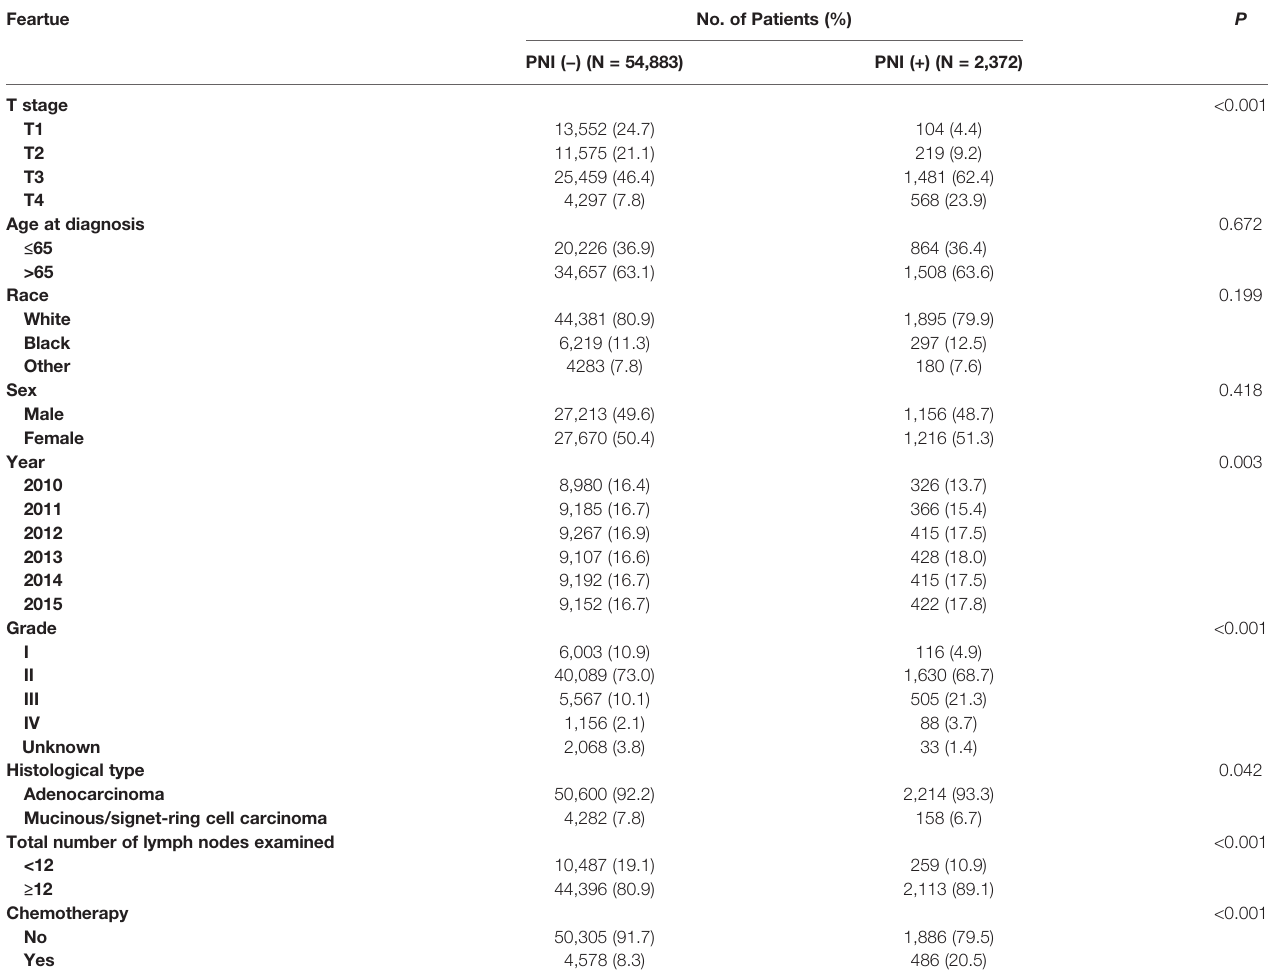
TABLE 1 | Demographic and clinical features of the patients according to perineural invasion status.